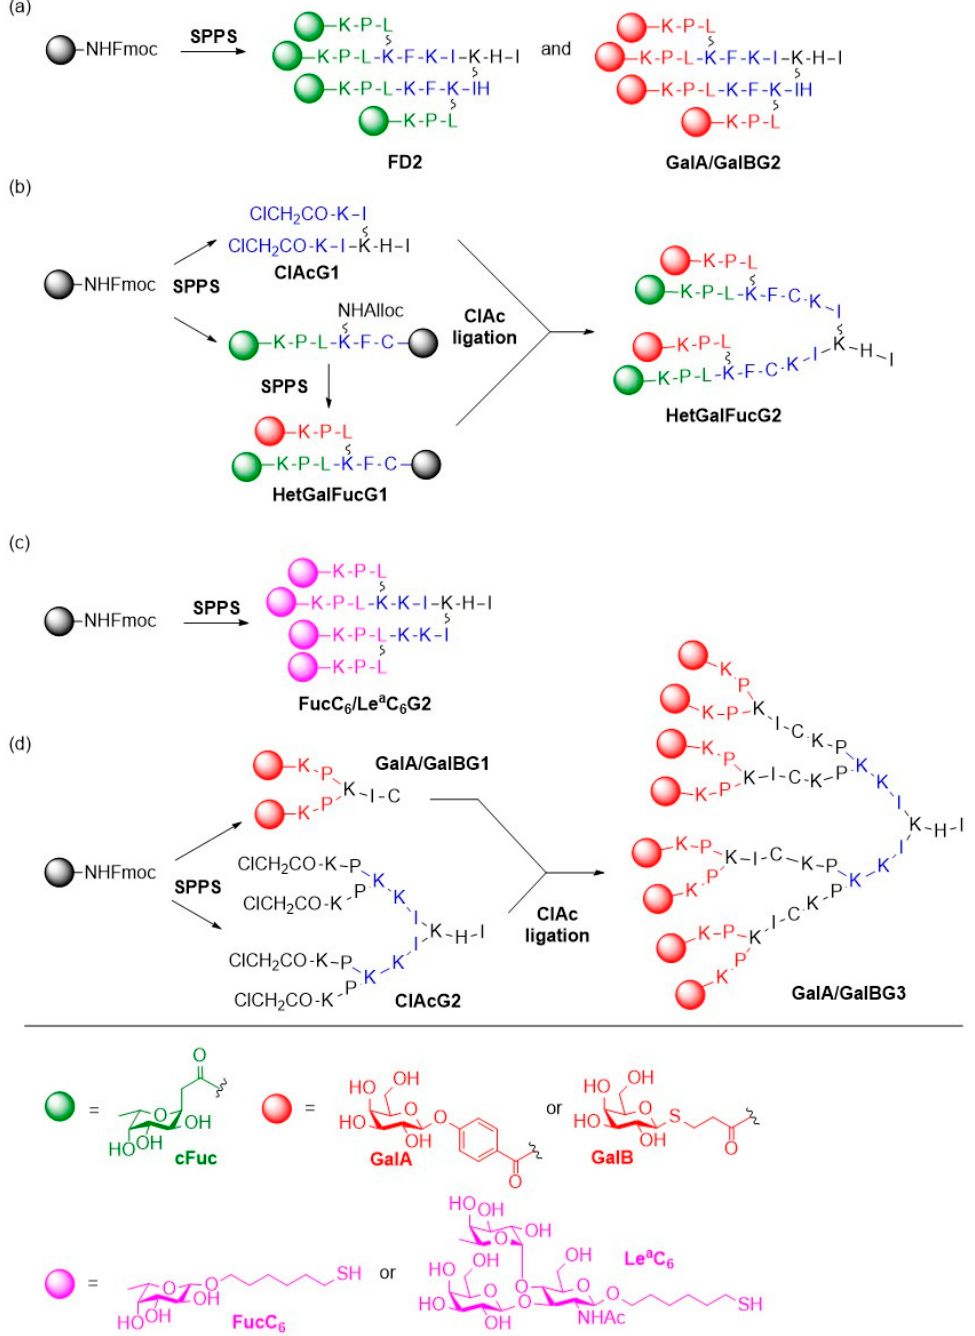
Figure 5. ( a ) Structure of the fucosylated FD2 and galactosylated GalA/GalBG2 glycodendrimers; ( b ) Synthesis of the heteromultivalent fucose- and mannose-functionalized glycodendrimer via SPPS and chloroacetyl cysteine thioether ligation; ( c ) Preparation of homomultivalent FucC 6 G2 and Le a C 6 G2 dendrimers; ( d ) Synthesis of octavalent galactosylated glycodendrimers.